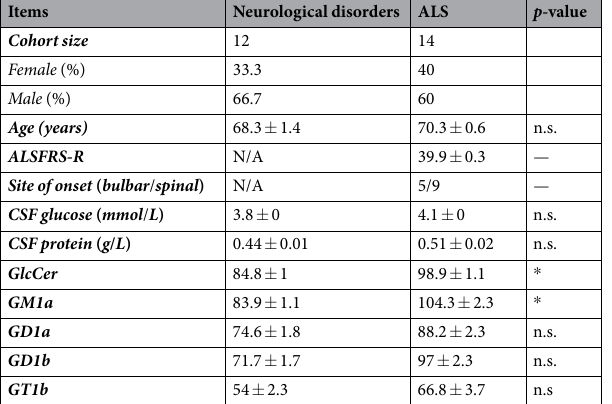
Table 1. Glycosphingolipid dysregulation in the cerebrospinal fluid of ALS patients. The characteristics and levels of glycosphingolipids of individuals diagnosed with non-ALS neurological disorders and ALS are shown. Glycosphingolipids are expressed as HPLC peak area/ µ l CSF, Mean ± SEM. * Corrected p -value <